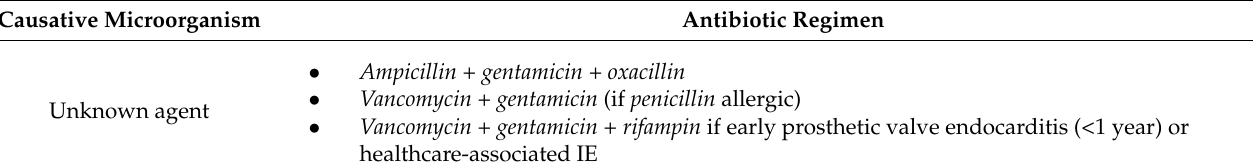
Table 6. Antimicrobial regimens according to etiology in pediatric infective endocarditis (IE) with the recommended week (w)